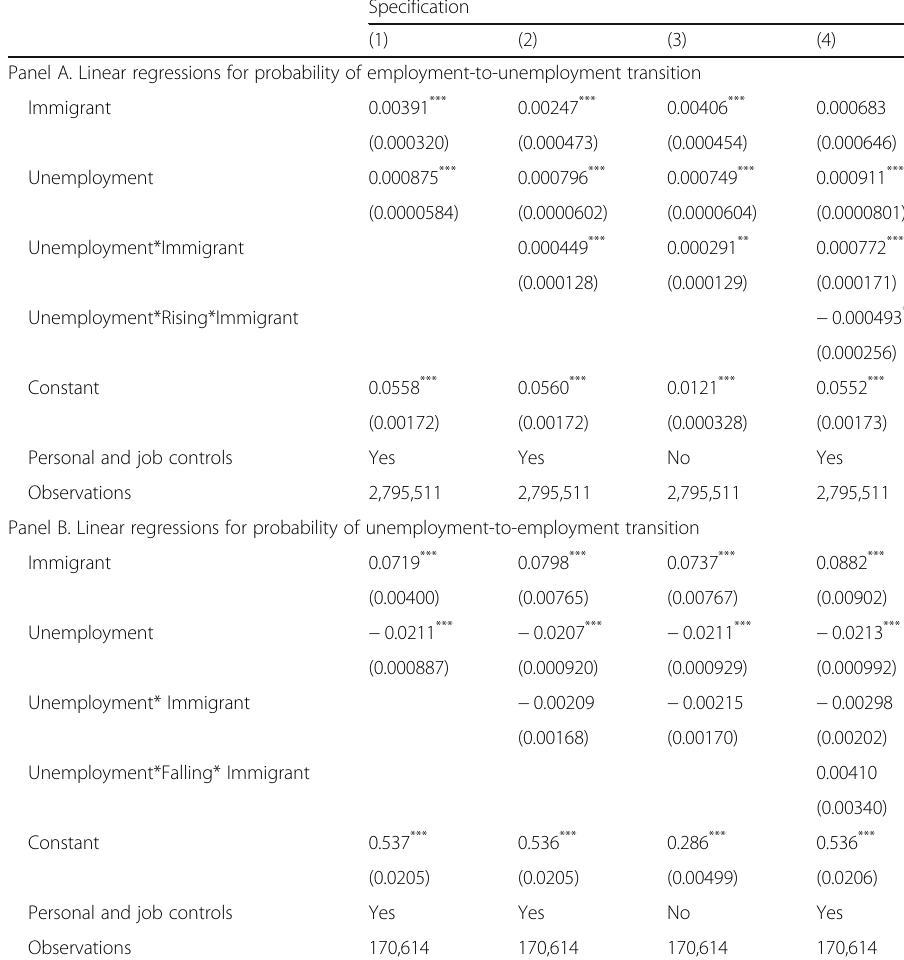
Table 13 Estimated transitions between employment and unemployment: matched CPS data, 2008 –